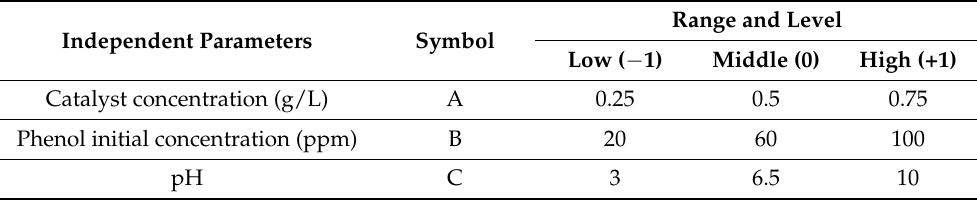
Table 1. Independent parameters and their ranges and levels.